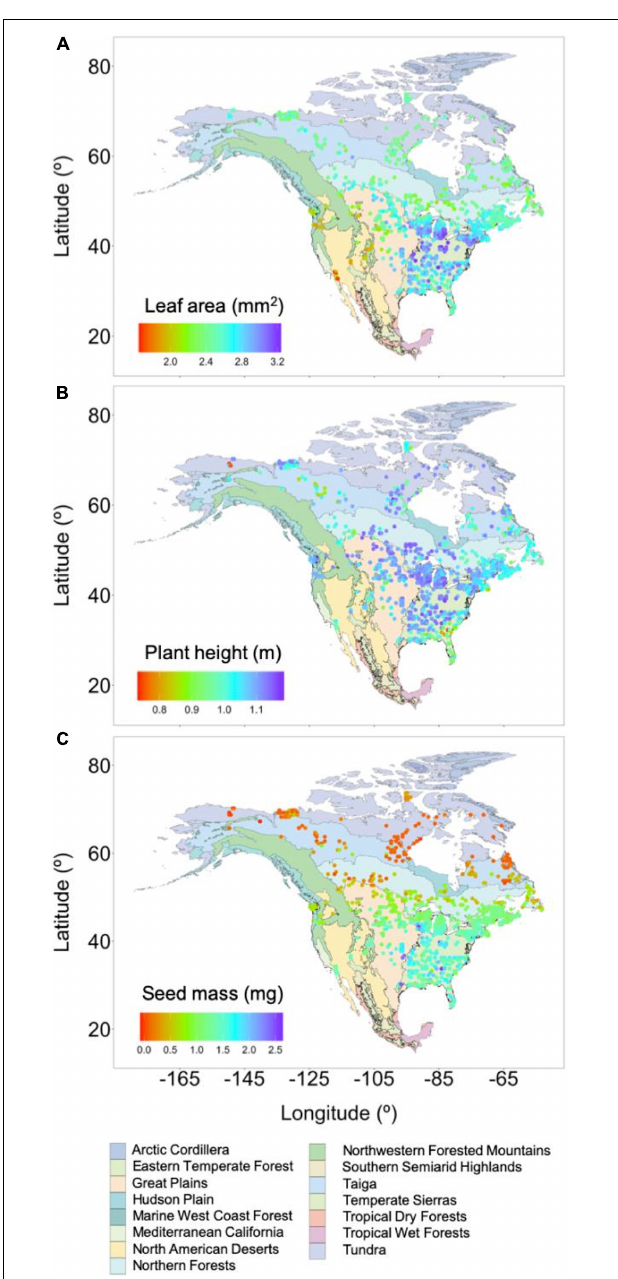
FIGURE 2 | Gridded and log-transformed leaf area (A) , plant height (B) , and seed mass (C) estimates from surface pollen samples against a backdrop of the continent’s ecoregions (Omernik, 1987) with mean grid cell values colored on a log scale. Generalized least squares regression found the seed mass trend was significantly related to latitude.